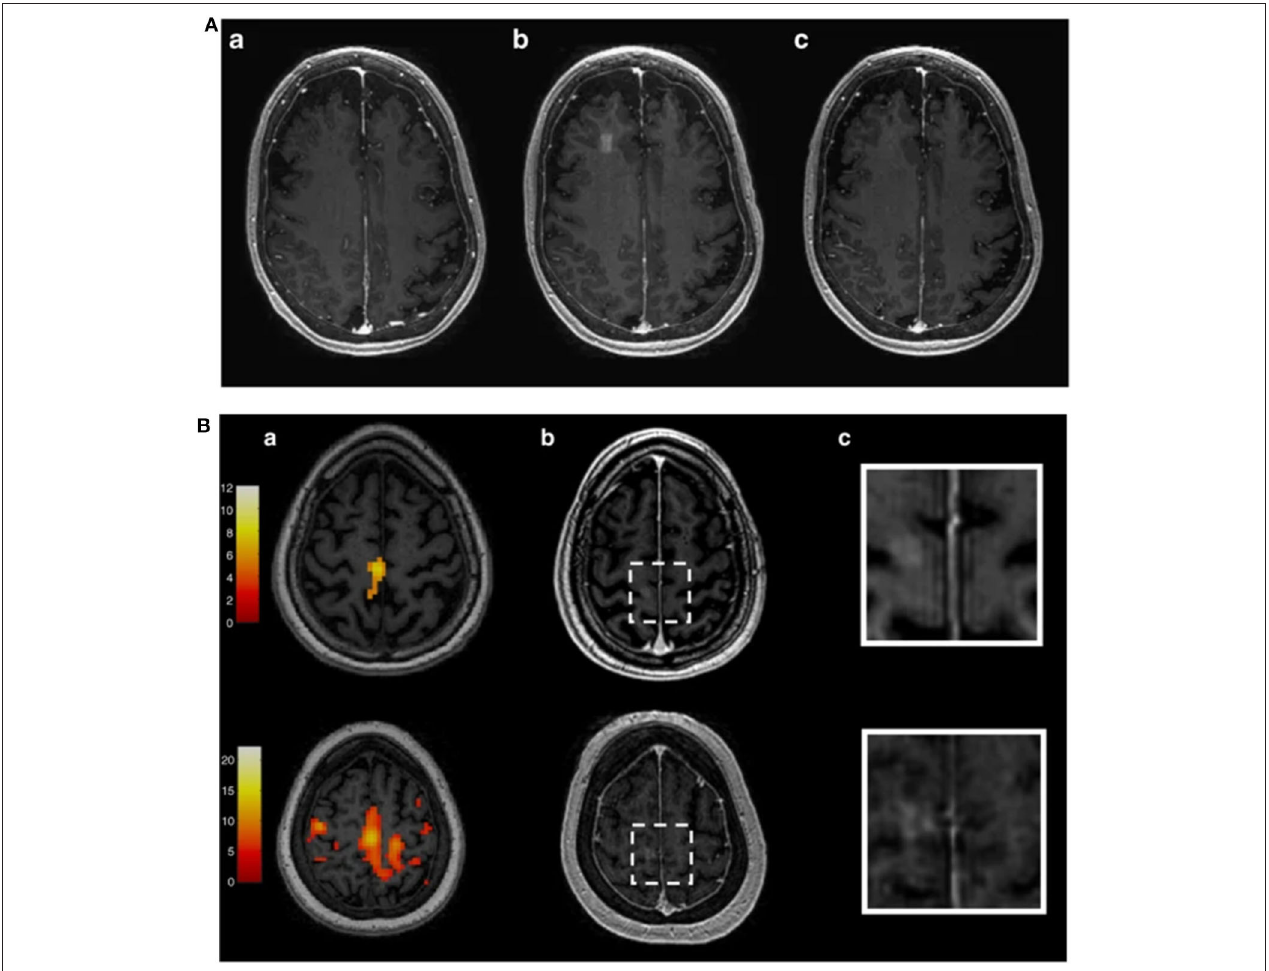
FIGURE 5 | (A) : Contrast-enhanced T1-weighed MR images obtained before (a), immediately (b), and 24h (c) after BBB opening [32]. Figure reproduced with permission from [32]. (B) : fMRI images used by [75] to specifically target the US to the primary motor cortex in a human subject. BBB opening has been then evaluated through the acquisition of Contrast-enhanced T1-weighed MR images (b,c). Figure reproduced with permission from [